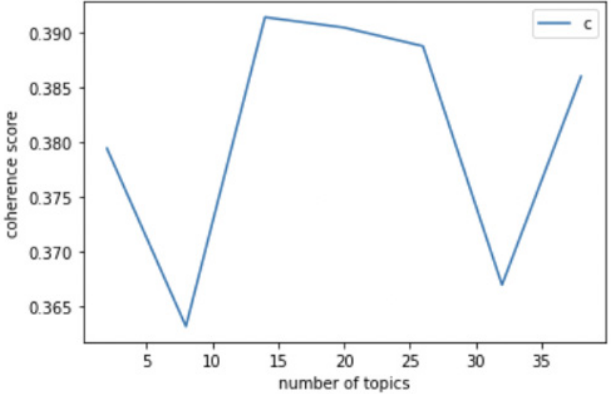
Figure 3. Coherence scores used to select the optimal number of topics.